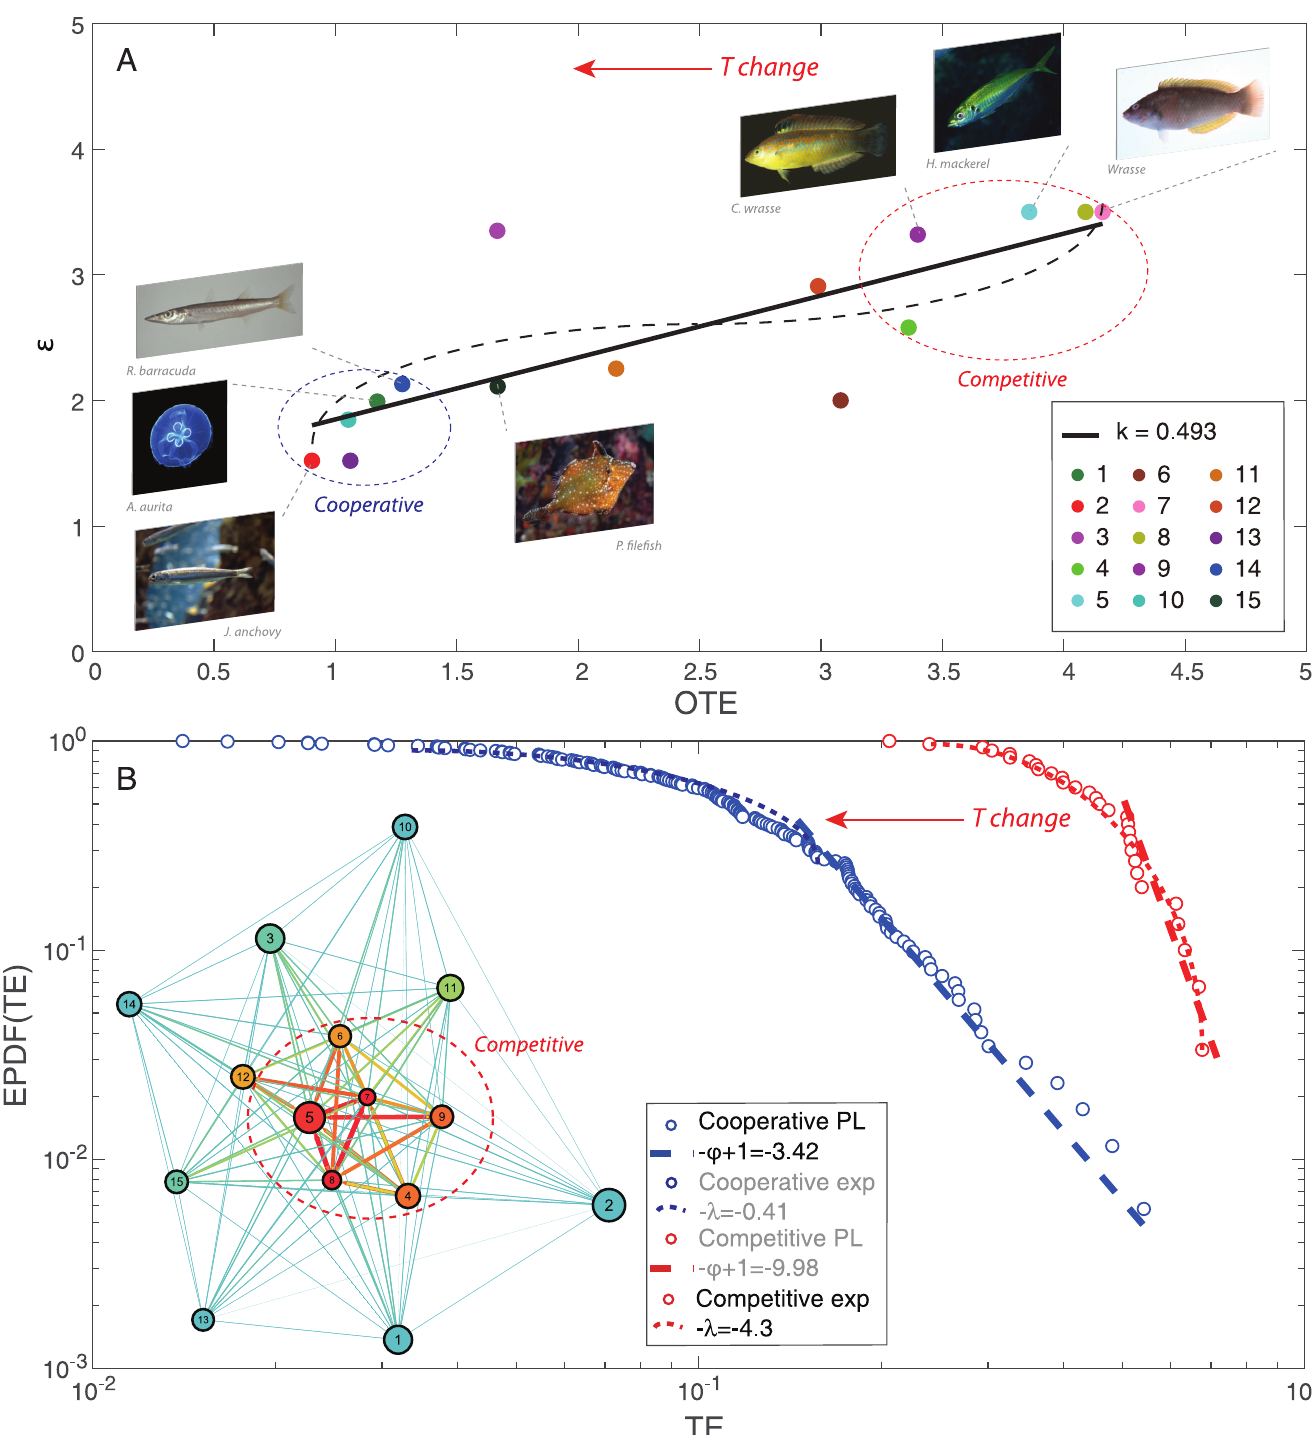
Fig 8. Abundance-interaction atemporal pattern and distribution of species interactions for competitive and cooperative species. (A) Considering the whole time period for the 15 species, � is the slope of the Zipf’s law (on pdf) of species abundance (see Fig 3) and OTE is the sum of all interactions of a species (that is how much one species influences the collective on average). Black continuous and dashed curves are the linear and non-linear (second-degree polynomial) fitting for the abundance-interaction pattern. Cooperative species, asynchronized with temperature, are characterized by more power-law distributed fluctuations in abundance (see S1, S3 and S4 Figs) manifested by the lower � and wide scale-free distributed total interactions (Figs 4 and 5, and 8B) (with relatively low average) that are more stable over time (Fig 6); this underlines the weak-interaction induced stability of ecosystems. Increasing temperature leads to a predominance of small-world distributed high